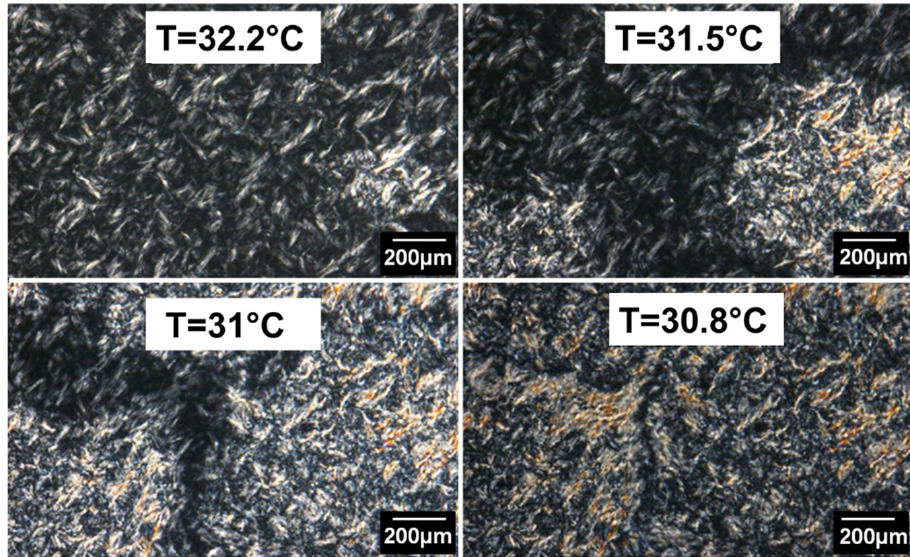
Figure 14. PEG spherulite crystallization in PE-b-PEG C observed by optical microscopy in combination with polarized light during a cooling ramp.